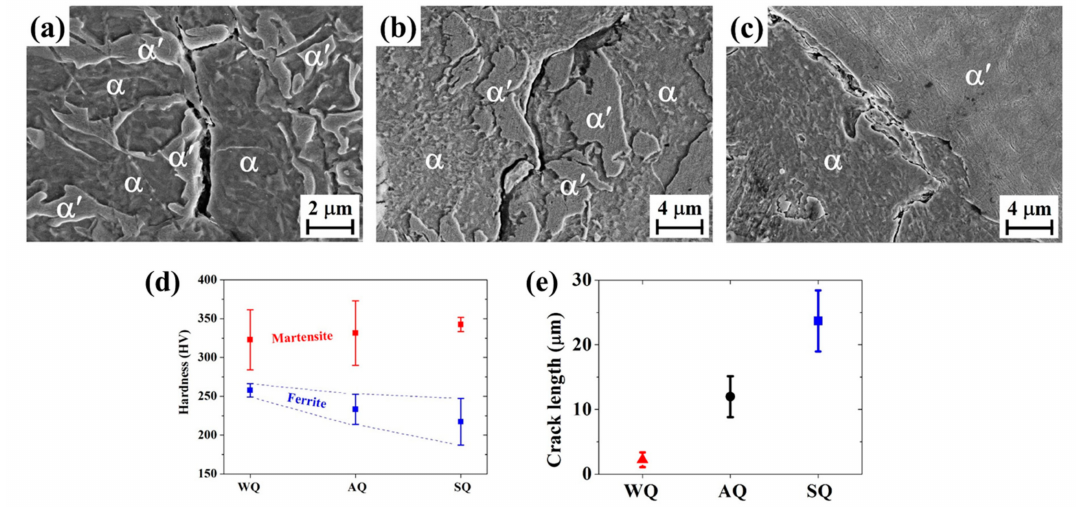
Figure 6. SEM micrograph of ( a ) WQ specimen, ( b ) AQ specimen, and ( c ) SQ specimen near the hole; ( d ) phase hardness and ( e ) crack length for the investigated specimens after the hole-expansion